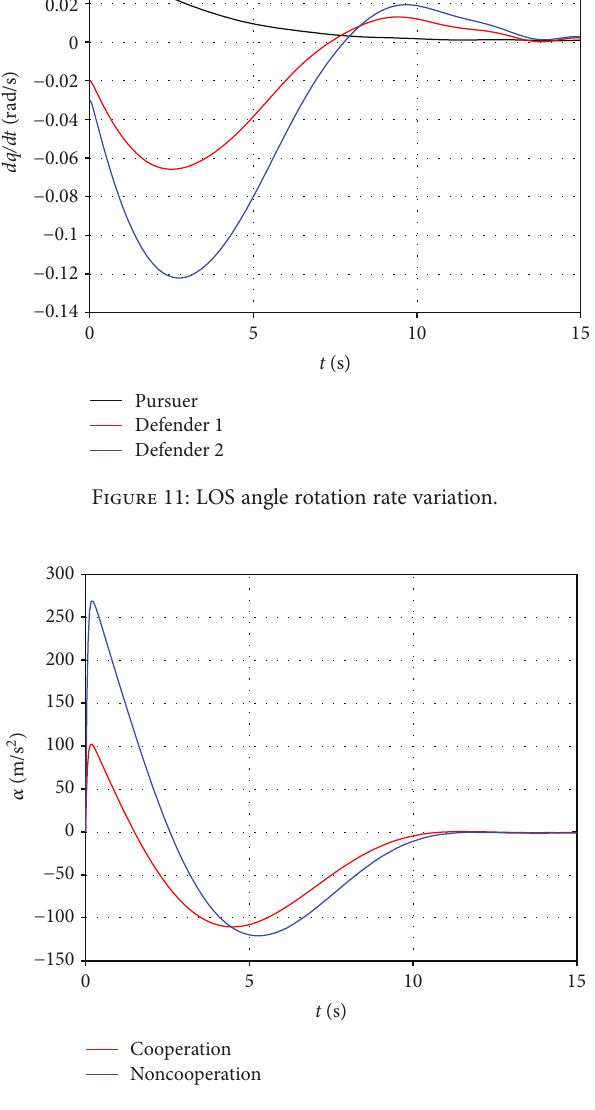
Figure 12: Acceleration variation of Defender 1 (one-side